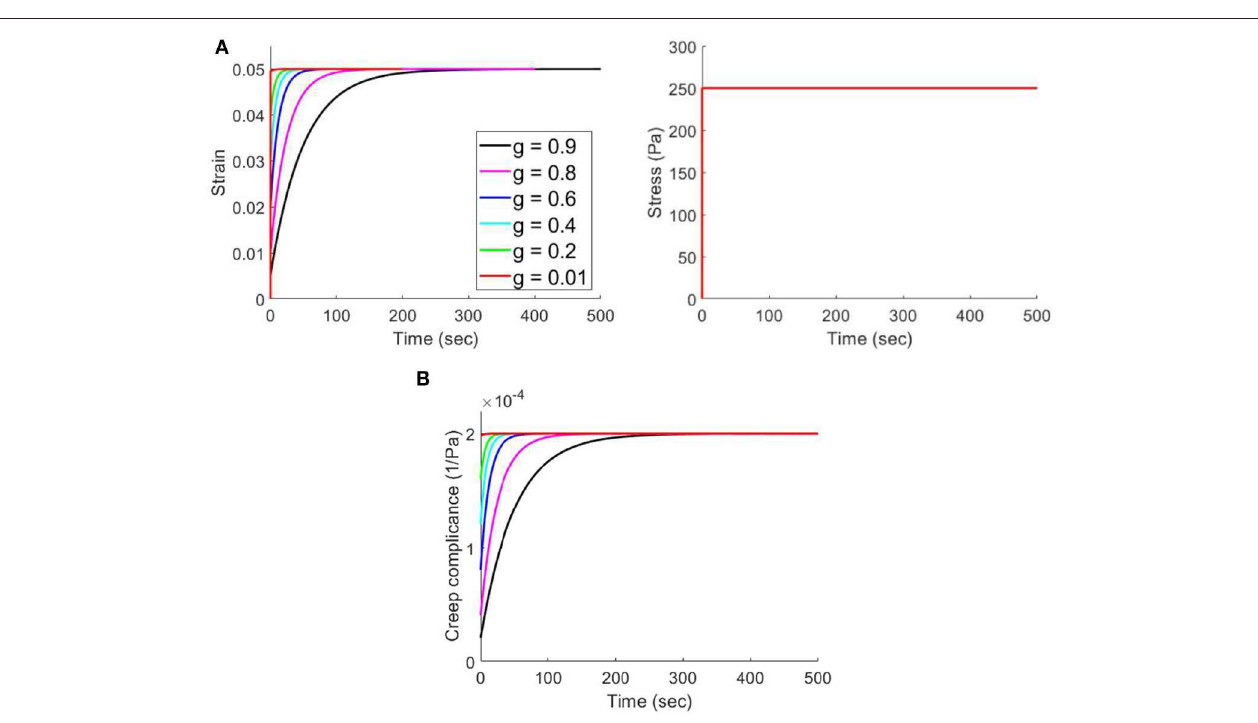
used to curve fit the simulated viscoelastic behavior to obtain the corresponding viscoelastic properties. Third, if the evaluated viscoelastic properties obtained by curve fitting are similar to